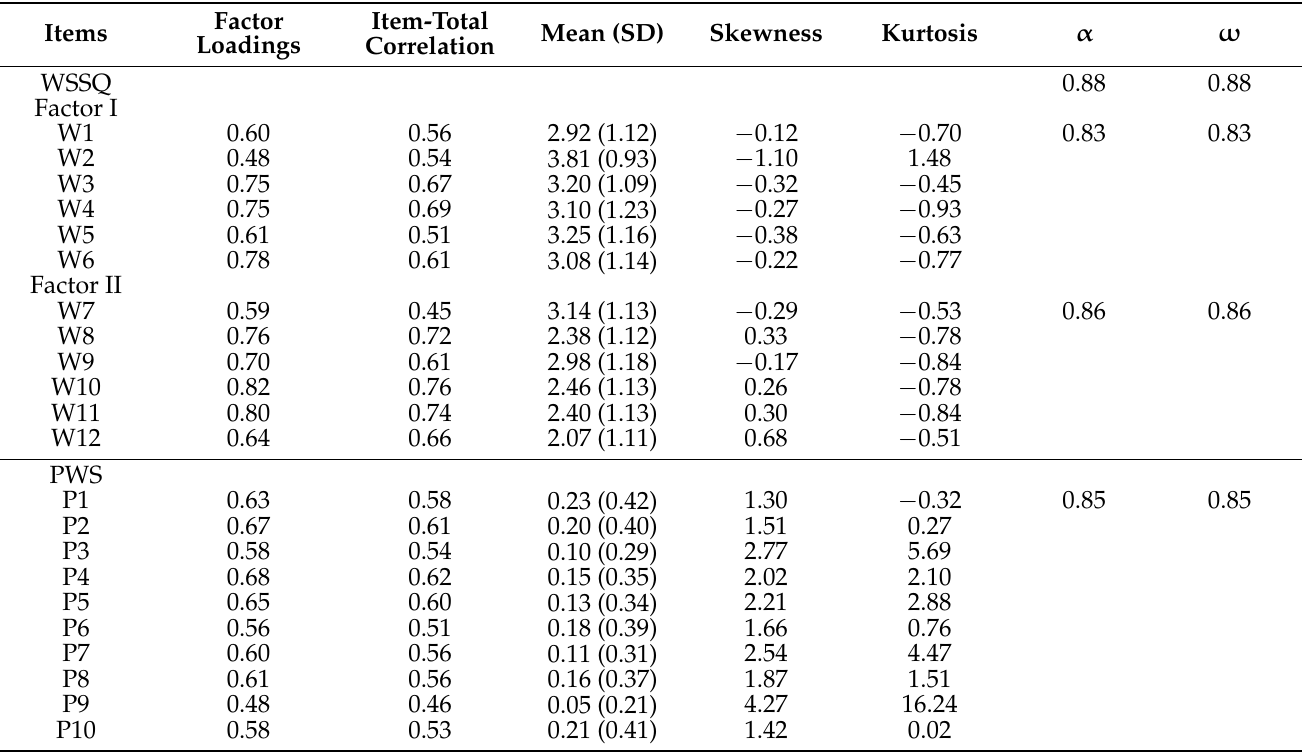
Table 1. Item statistics and reliability for WSSQ and PWSS.